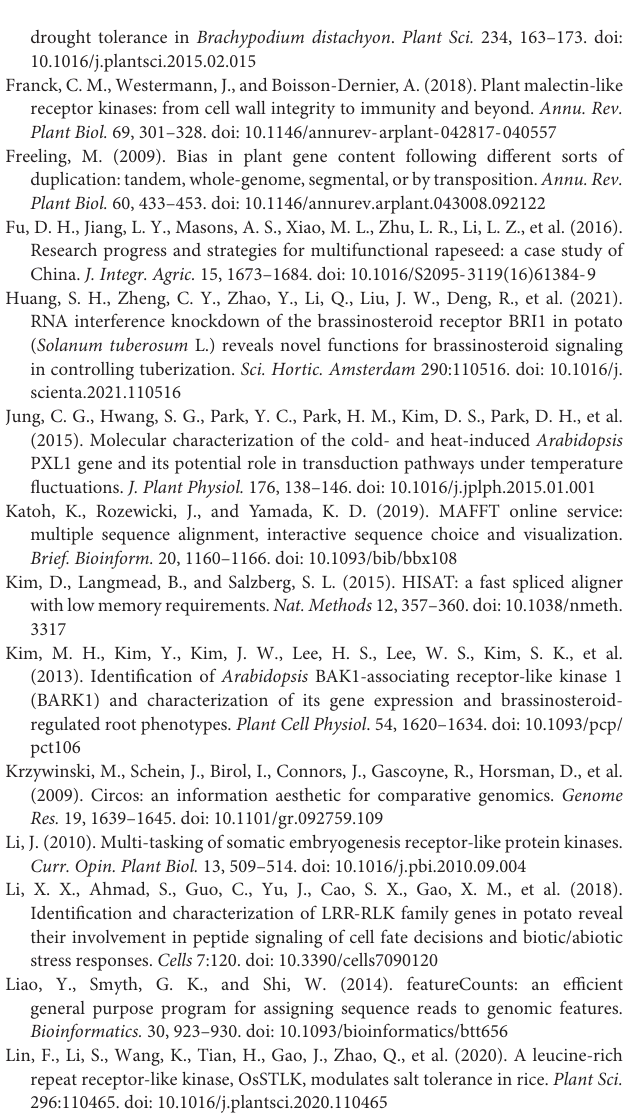
Supplementary Figure 5 | Sequencing chromatograms of positive single clones in T 3 generation. Each single clone was evaluated by Sanger sequencing. The inserted nucleotides are highlighted with yellow colors, pointing by black arrows. Supplementary Figure 6 | Sequencing chromatograms of PCR products in T 3 generation. Each PCR product was purified and sequenced. The inserted nucleotides are highlighted by black box. Supplementary Figure 7 | Expression of BnBRI1 genes in WT, L18 and L24. The BnUBC21 gene was used as an internal control. Error bars represent SE (standard errors) of three independent replicates. Different lowercase letters indicate values significant differences compared to WT at the level P < 0.05. Supplementary Figure 8 | Hypocotyl length and response to BRZ in gene edited lines. (A) Phenotypes of the gene edited lines at seedling stage. (B) The gene edited lines under BRZ treatment. (C) Hypocotyl length of seedlings shown in (A) . Data are the mean ± SD ( n = 15), scale bars, 1 cm. (D) Hypocotyl length of seedlings at different BRZ concentrations shown in (B) , scale bars, 1.5 cm. Different letters indicate significant differences based on one-way ANOVA ( P <